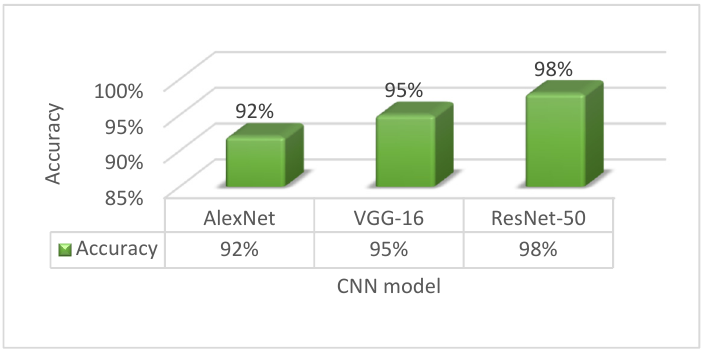
Figure 8. Validation accuracy of selected CNNs model.